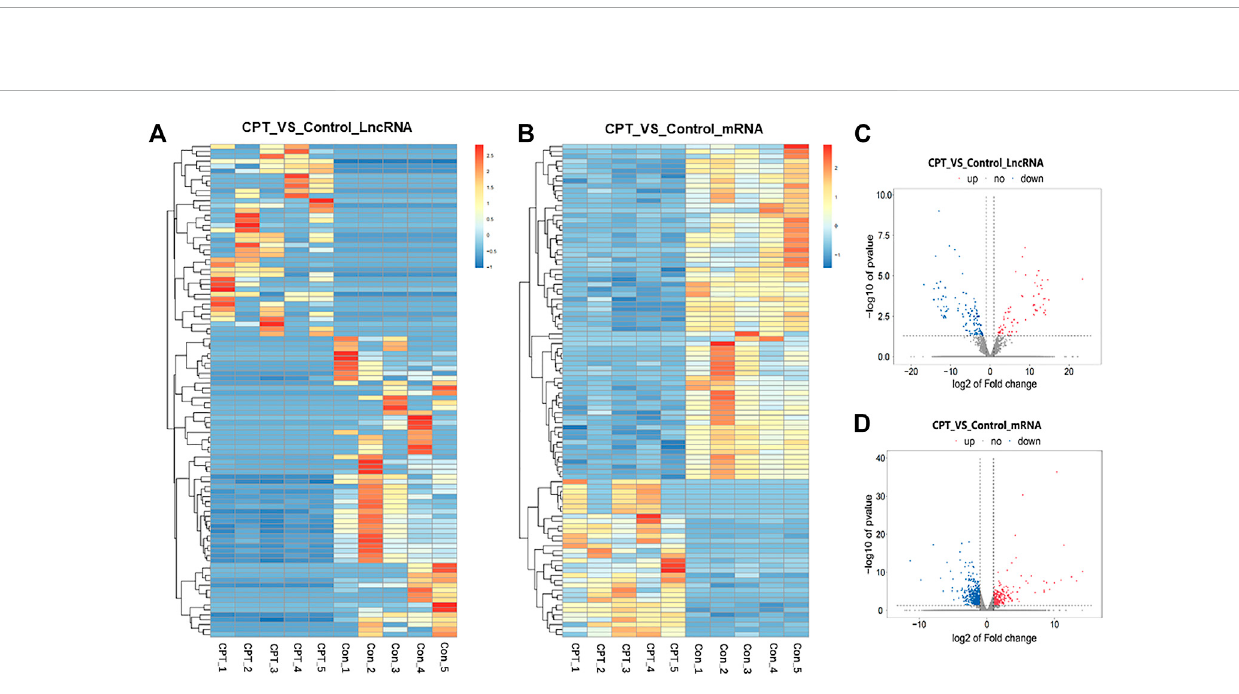
FIGURE 3 (A) , the fi rst 100 lncRNAs with the smallest p -value were plotted by heat map. (B) , the fi rst 100 mRNAs with the smallest p -value were plotted by heat map. (C) , the expression difference of lncRNA in normal and CPT PSCs was analyzed by volcanic map. (D) , the expression difference of mRNA in normal and CPT PSCs was analyzed by volcanic map. CPT, congenital pseudarthrosis of the tibia; PSCs, periosteal stem